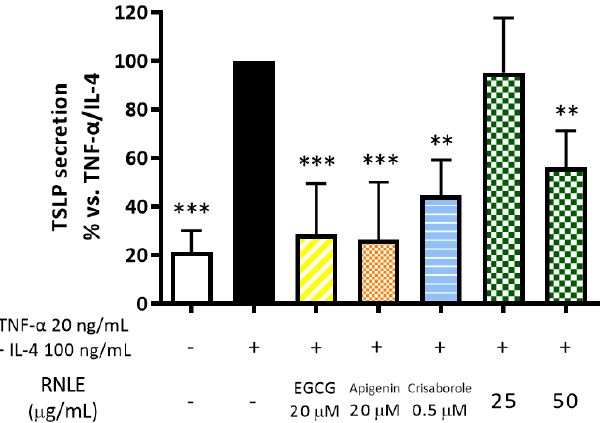
Figure 10. Effect of RNLE treatment (25–50 µg/mL) on TSLP secretion in differentiated HaCaT cells stimulated with a combination of IL-4 and TNF- α (100 ng/mL + 20 ng/mL, 24 h); the absolute stimulated with a combination of IL-4 and TNF-α (100 ng/mL + 20 ng/mL, 24 h); the absolute amount amount of TSLP in the stimulated condition was 65.05 ± 31.91 pg/mL. ( − )-Epigallocatechin 3-gallate of TSLP in the stimulated condition was 65.05 ± 31.91 pg/mL. (−)-Epigallocatechin 3-gallate (EGCG) 20 µM, apigenin 20 µM, and crisaborole 0.5 µM were used as the reference compounds; ** p < 0.01, (EGCG) 20 µ M, apigenin 20 µ M, and crisaborole 0.5 µ M were used as the reference compounds; *** p < 0.001 vs. stimulus. ** p < 0.01, *** p < 0.001 vs.